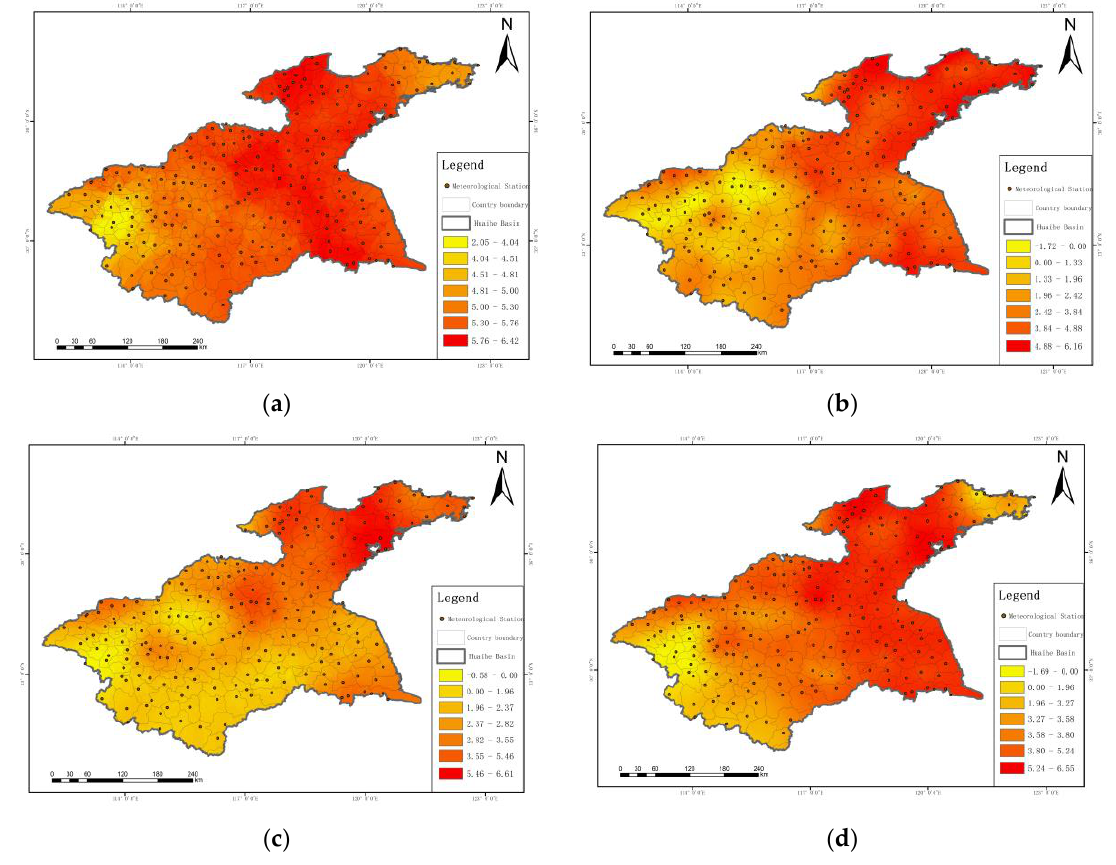
Figure 4. Spatial distribution of Z-values of mean temperatures in different seasons. ( a ) Spring, ( b ) Summer, ( c ) Autumn and ( d ) Winter.